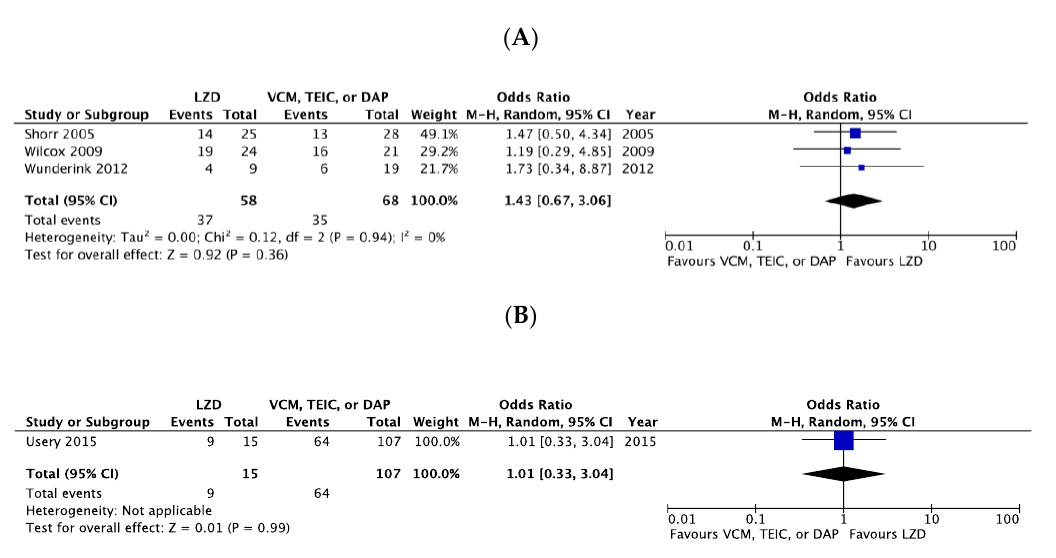
Figure 3. Forest plots of clinical cure rates in patients with MRSA bacteremia treated with LZD versus VCM, TEIC, or DAP. ( A ) RCTs; ( B ) CSs. The vertical line indicates no significant difference between the compared groups. Mantel–Haenszel ORs are represented by diamond shapes, and 95% CIs are represented by horizontal lines. Squares indicate point estimates, and the square size indicates the weight of each study included in the meta-analysis. MRSA, methicillin-resistant Staphylococcus aureus ; RCTs, randomized controlled trial; CSs, case-control and cohort studies; CI, confidence interval; LZD, linezolid; VCM, vancomycin; TEIC, teicoplanin; DAP, daptomycin; OR, odds ratio.